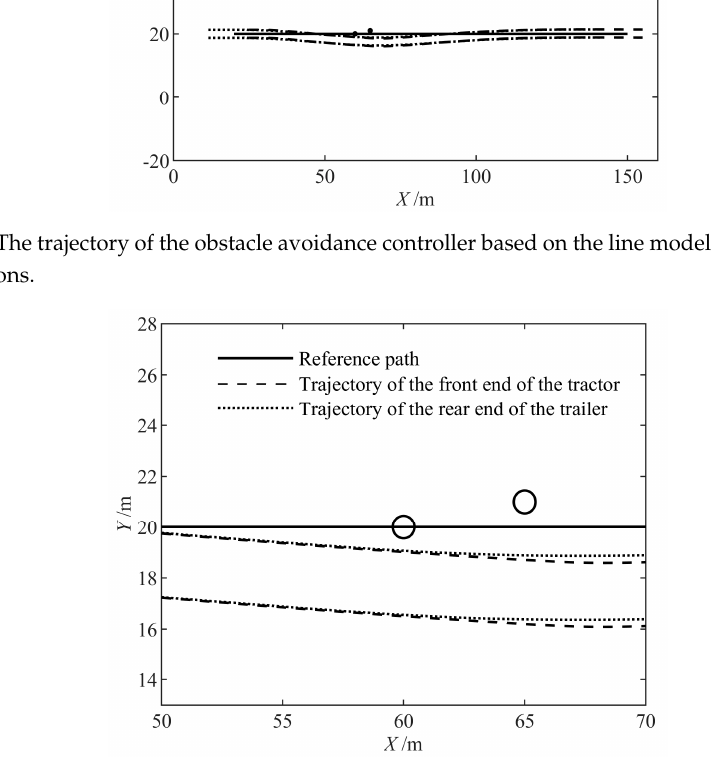
Figure 24. Partially enlarged view of Figure 23.